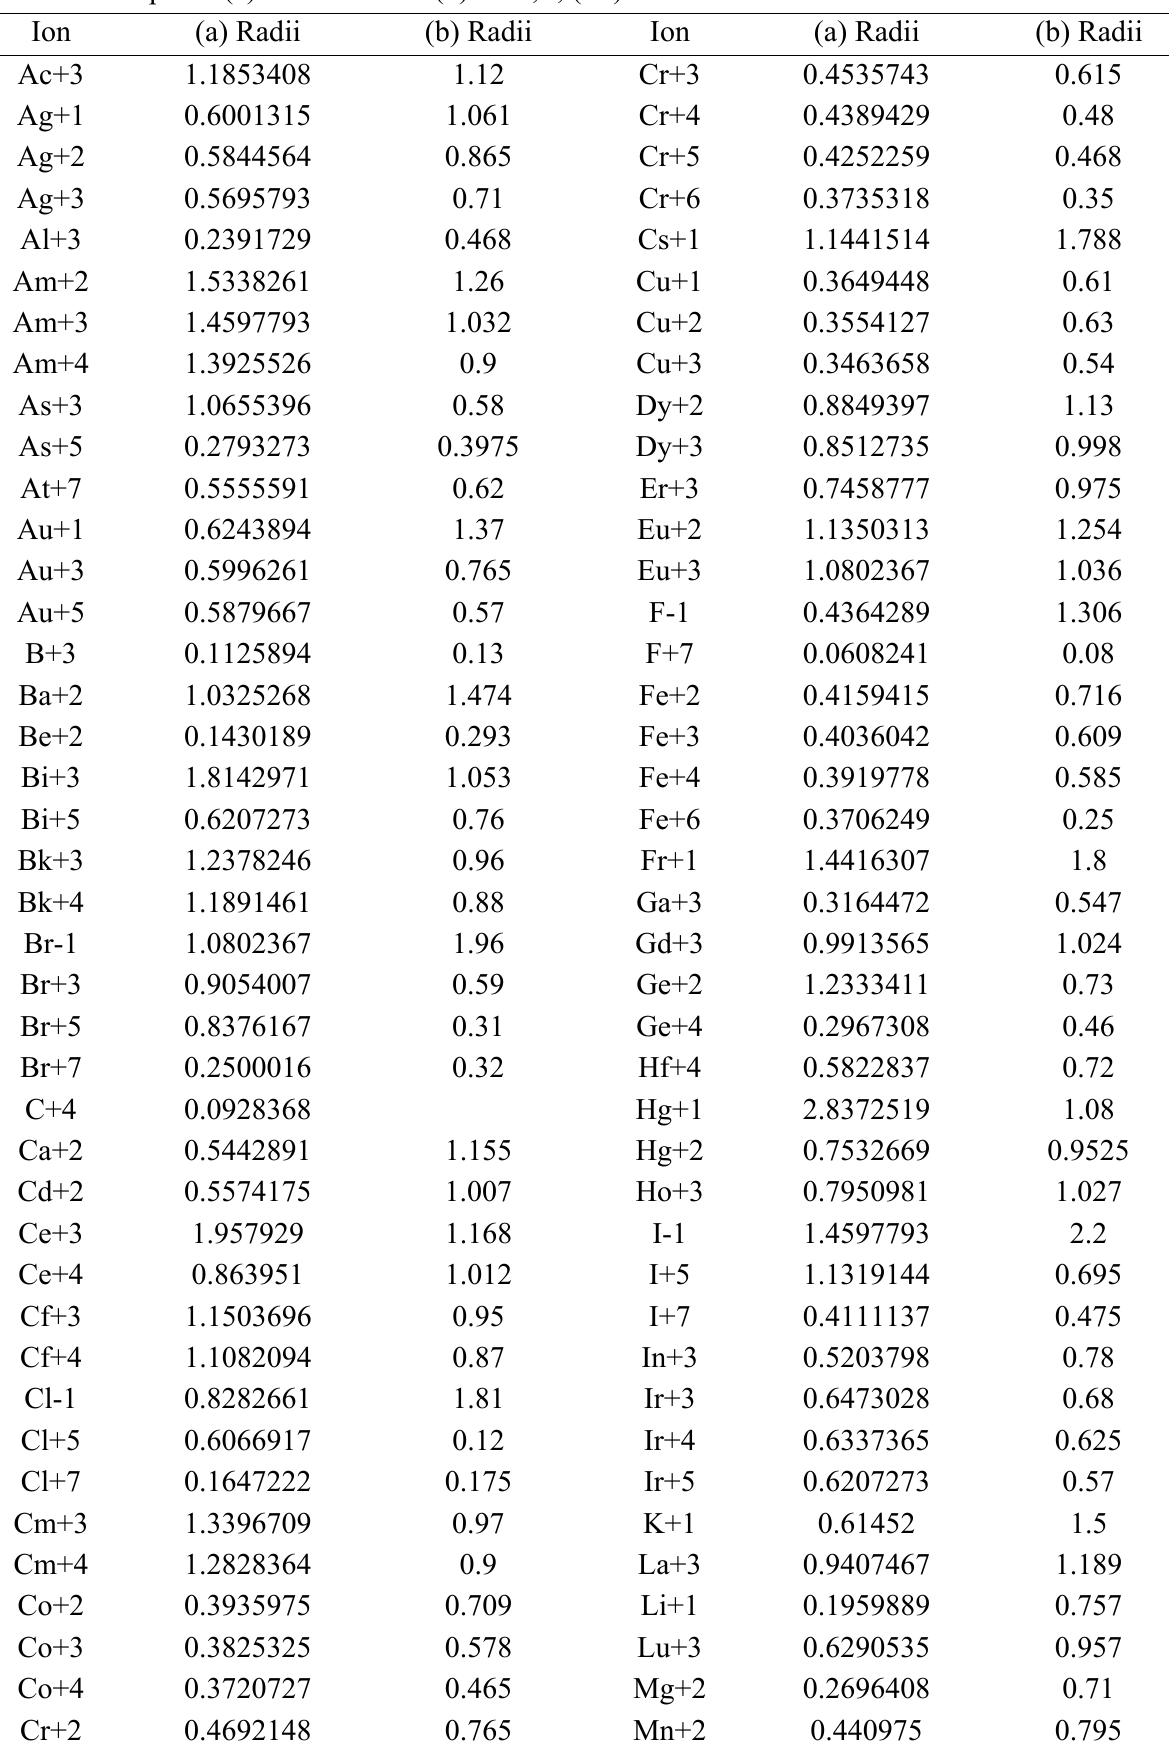
Table 1. Computed (a) and Shanon’s (b) radii, r, (A 0 ) of